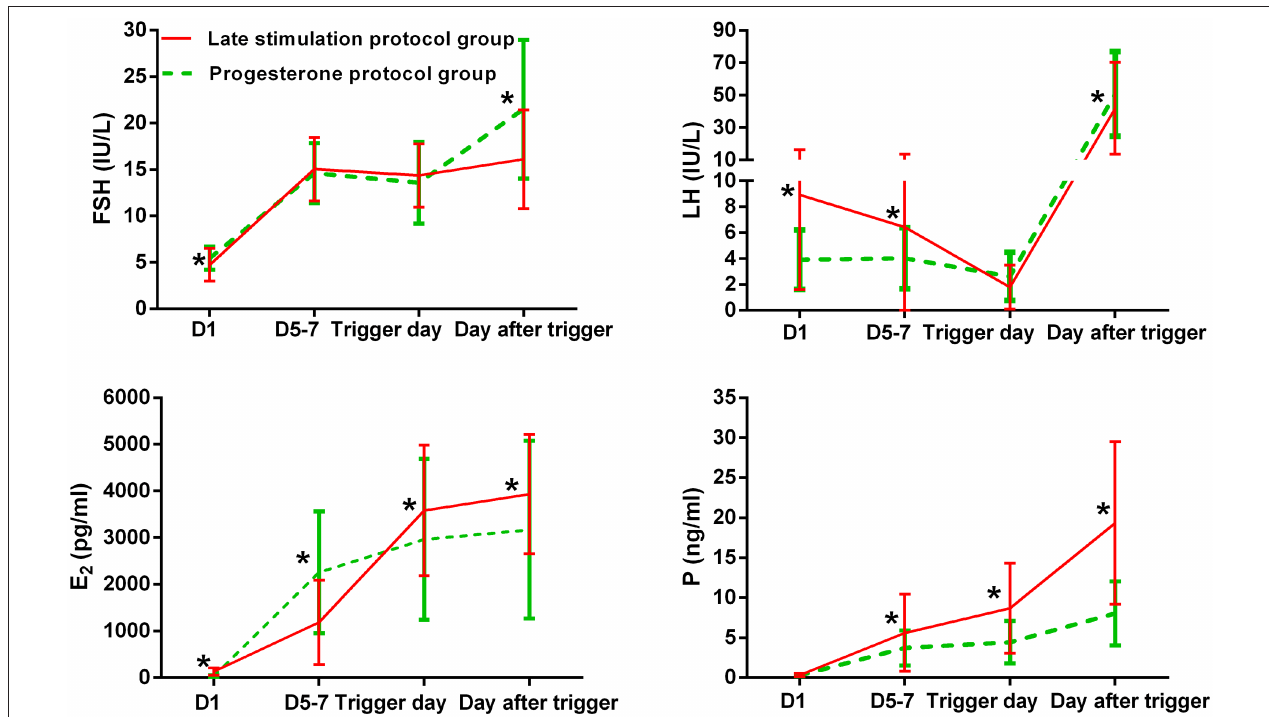
FIGURE 2 | Serum hormonal profiles during ovarian stimulation in the two groups. The green lines represent the control group (progesterone protocol group), and the red lines represent the study group (late stimulation protocol group). *Time point at which P < 0.05. The initial day of ovarian stimulation is denoted as day 1 (D1). FSH, follicle-stimulating hormone; LH, luteinizing hormone; E 2 , estradiol; P,